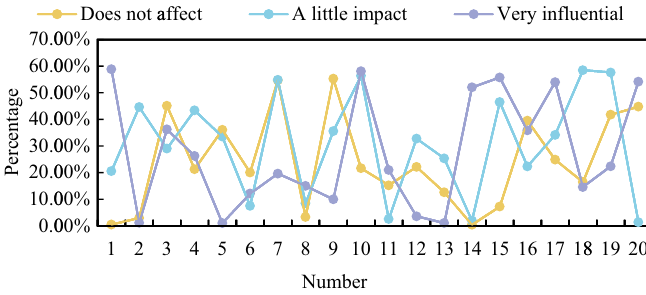
Figure 4: Degree of in fl uence of brand image on consumer patronage.